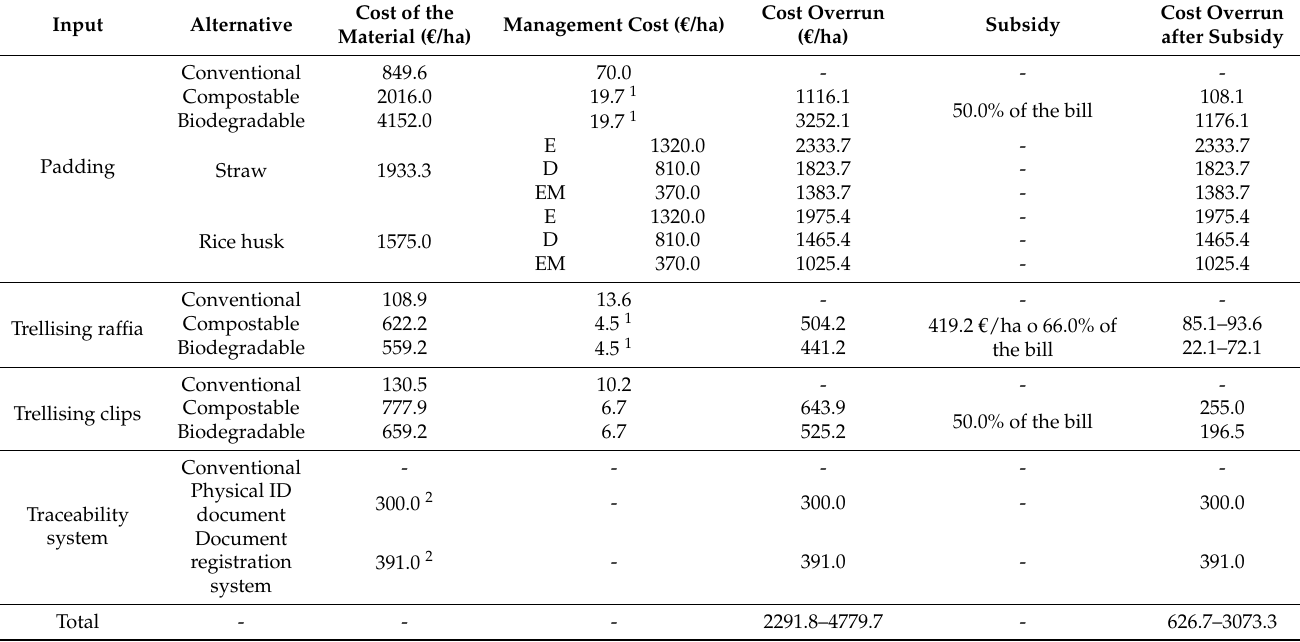
1 Proportional cost of external management of plant residues; 2 excluding administrative fee. E: sanding; D: bare soil; EM: mechanical sanding. Source: own elaboration based on data provided by other authors [68,69], documents obtained from the Reinwaste project website [63,66,67] and consultations with specialized supply